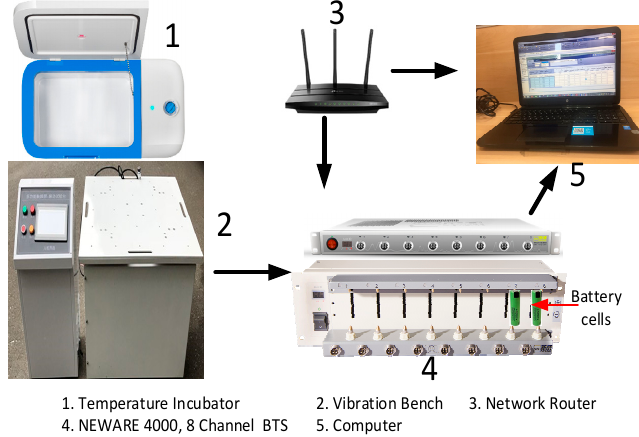
Figure 7. Experimental test bench with vibration and temperature chambers.